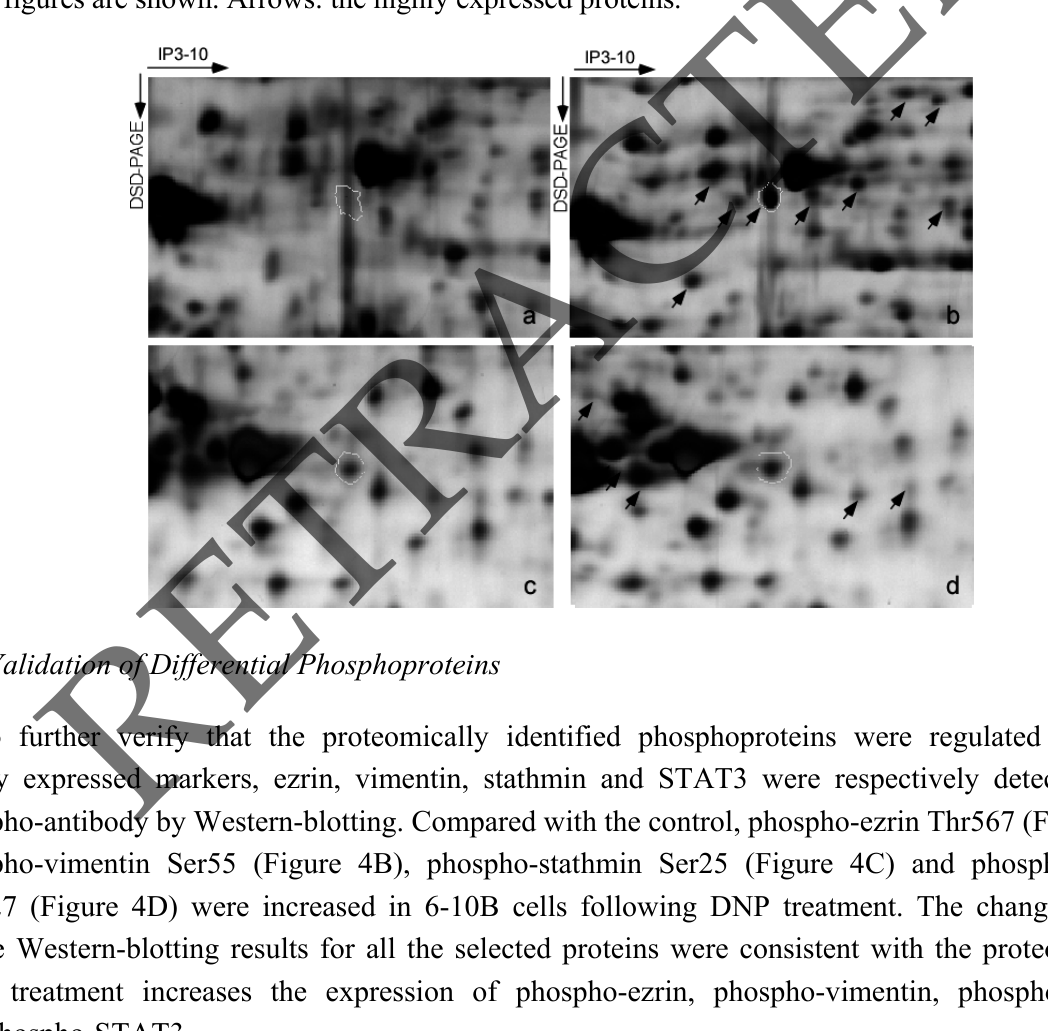
Figure 3. Proteomic analysis of phosphoproteins mediated by DNP. The total proteins in 6-10B cells with or without DNP treatment were extracted, and the phosphoproteins were immunoprecipitated (IPed) using a phosphoserine-antibody or phosphothreonine-antibody respectively. The IPed proteins were then separated on an IPG strip (pH 3-10L, 180 mm × 3 mm × 0.5 mm) on IPG phor (Amersham Biosciences, Piscataway, NJ, USA) and were run through a 9%–16% SDS-PAGE (Bio-Rad, Hercules, CA, USA) as per the manufacturer’s instructions. After electrophoresis separation, the protein spots were visualized by silver-based staining technique with the protein silver stain kit (Amersham Biosciences). ( a ) IP protein with serine-antibody in 6-10B cells treated with 0.01% DMSO; ( b ) IP protein with serine-antibody in 6-10B cells treated with 4 μ M DNP; ( c ) IP protein with threonine-antibody in 6-10B cells treated with 0.01% DMSO; ( d ) IP protein with threonine-antibody in 6-10B